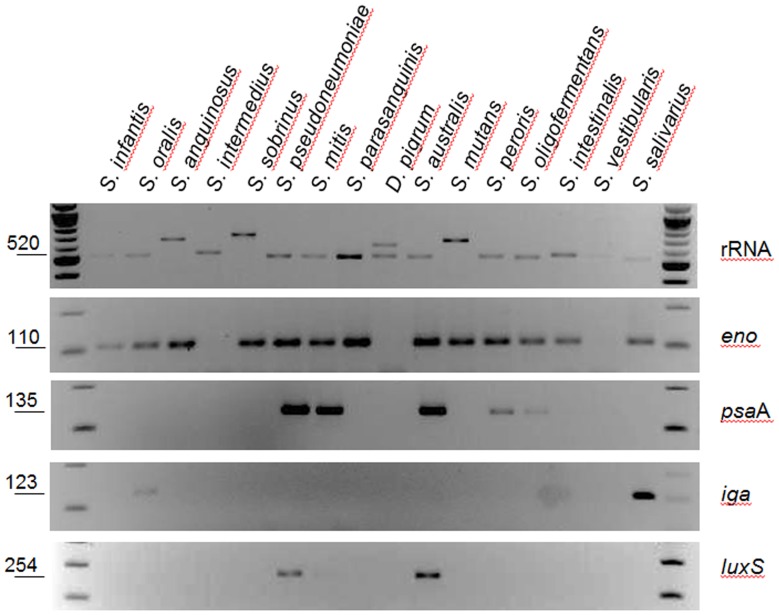
Primers designed to amplify S. pneumoniae genes amplify genes in related species.Purified DNA (100 pg) from the indicated species was utilized as template in PCR reactions. Specific genes amplified in those reactions are shown at right of each panel. The size of the expected product, in base pairs, is shown to the left.